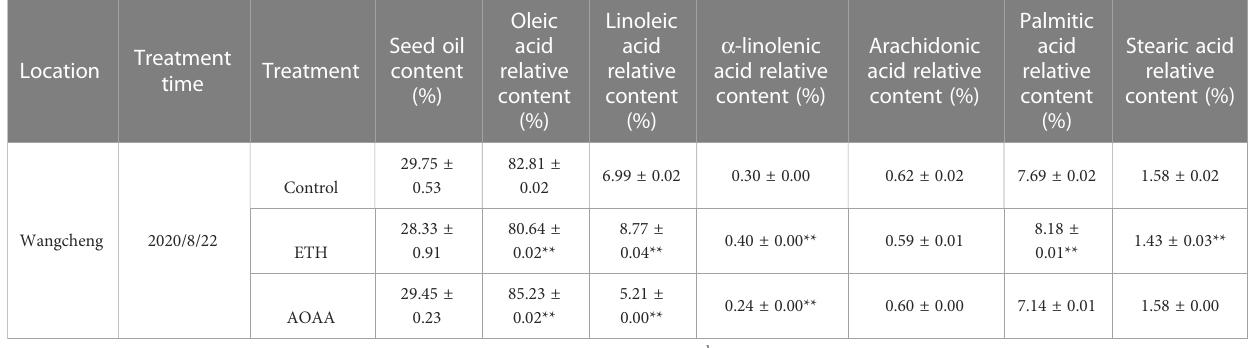
TABLE 1 Oil and relative fatty acid contents of the treatments and control in ‘ Huashuo ’